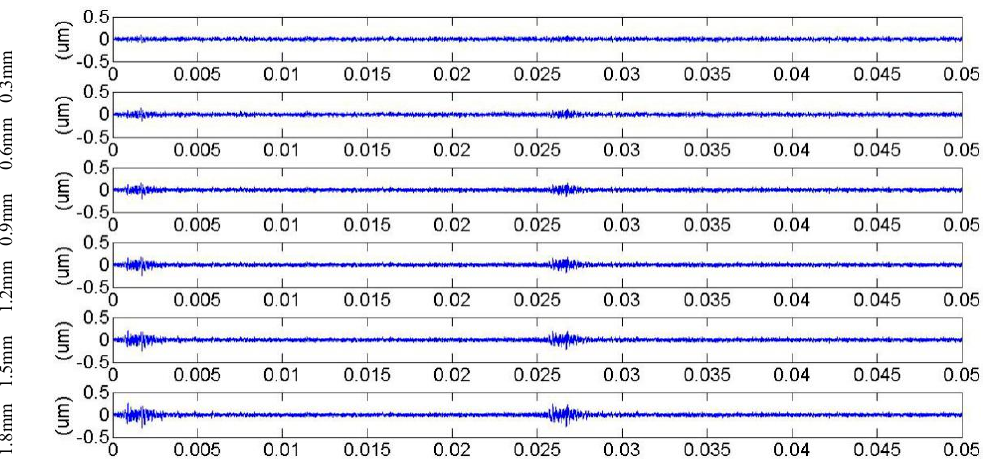
Figure 10. Vibration response for the cracked gear under the 14.5° pressure angle.